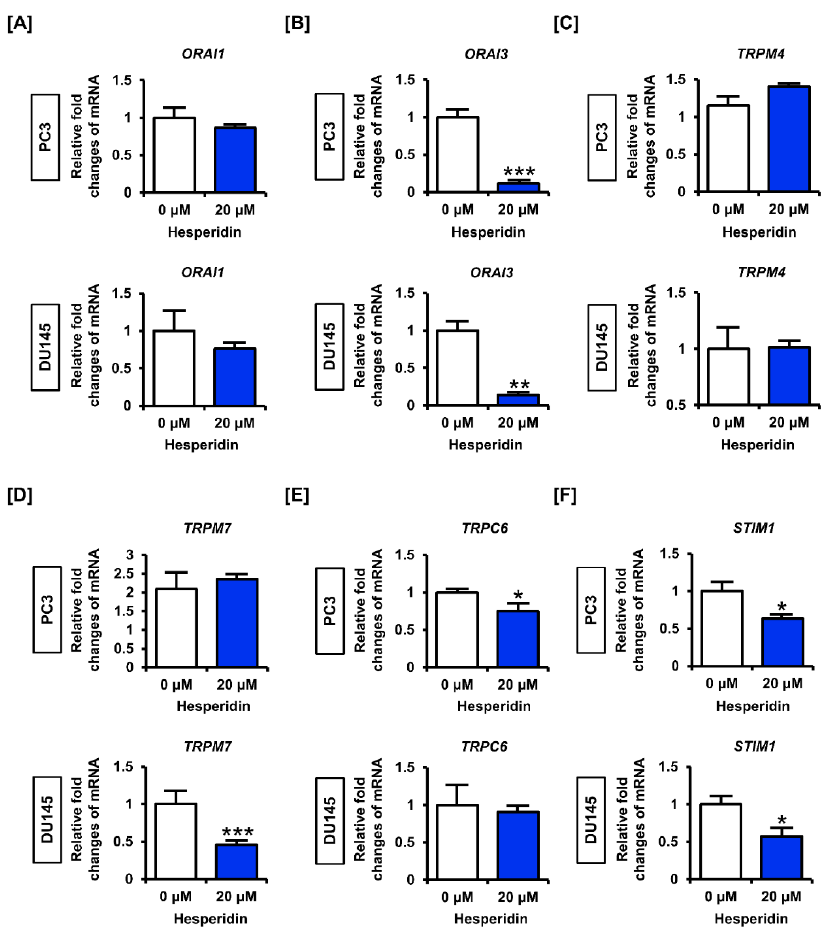
Figure 5. Effect of hesperidin on the expression levels of genes related to the store operated calcium entry (SOCE) in prostate cancer cells. ( A – F ) Expression levels of calcium release-activated calcium mod- ulator ( ORAI )- 1 ( A ), ORAI3 ( B ), transient receptor potential cation channel subfamily M ( TRPM )- 4 ( C ), TRPM7 ( D ), transient receptor potential cation channel subfamily C member 6 ( TRPC6 ) ( E ) and stromal interaction molecule 1 ( STIM1 ) ( F ) in PC3 and DU145 cells following hesperidin treatment were de- termined via quantitative polymerase chain reaction (qPCR). Expression of glyceraldehyde 3-phos- phate dehydrogenase ( GAPDH ) was used for normalization. All results of the arithmetic mean ( n = 3) denote statistical significance with asterisks (* p < 0.05, ** p < 0.01, and *** p < 0.001). 3.6. Hesperidin Regulates the PI3K and MAPK Signaling Pathways in Prostate Cancer Cells We investigated whether hesperidin regulated the phosphorylation of proteins in- volved in the PI3K and MAPK signaling pathways, which are major signaling cascades